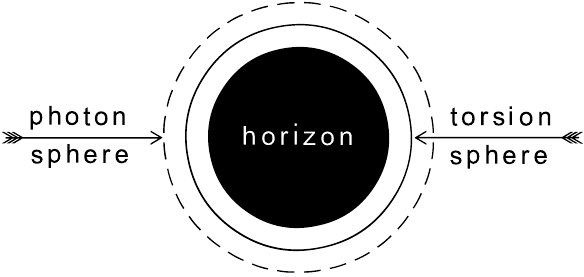
Fig. 1 The torsion sphere put to scalewith the photon sphere and event horizon Fig. 1 the latter is put to scale with the photon sphere and the original Schwarzschild horizon